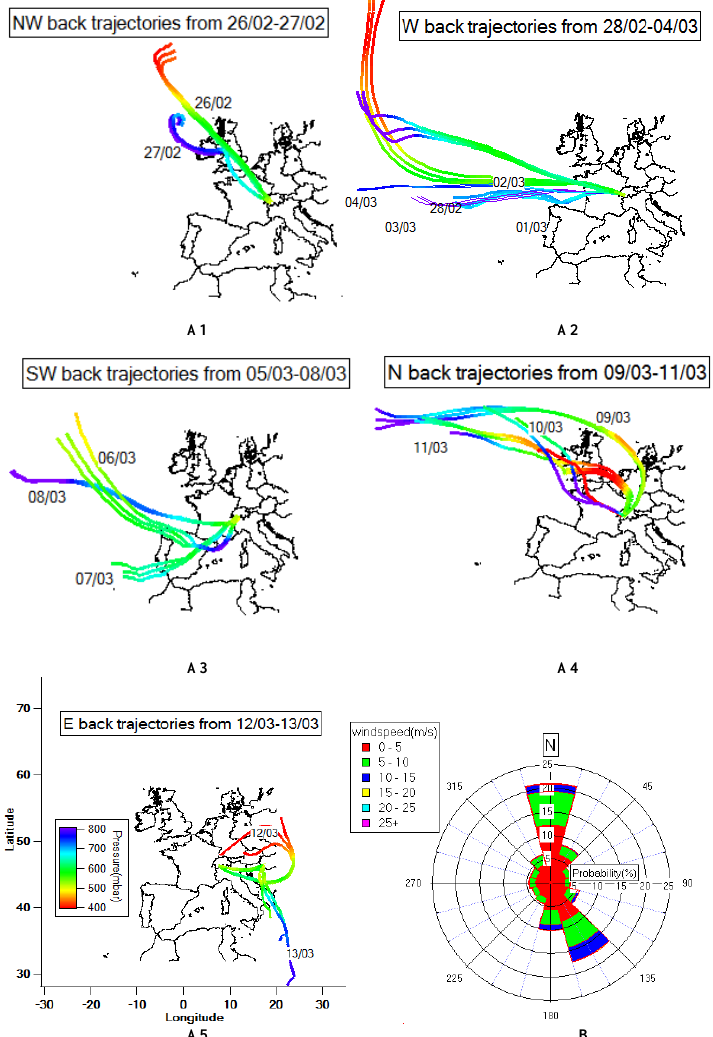
Fig. 1. Fig. 1. The experimental site was influenced by air mass history and local wind direction (A1–A5), back trajectory analysis calculated by NOAA Hybrid Single-Particle Lagrangian Integrated Trajectory model (HYSPLIT; Draxler, 2003). Time periods are classified according to the history of the air mass over the previous three days. Back trajectories are shown for arrival at 3400m, 3600m and 3800m a.s.l. over the Jungfraujoch, labelled by the arriving date and are coloured by air pressure. (B) Wind rose plot for the whole experiment period, individual wind direction measurements are accumulated and the relative frequency is shown as a percentage. The plot is coloured according to the probability of wind